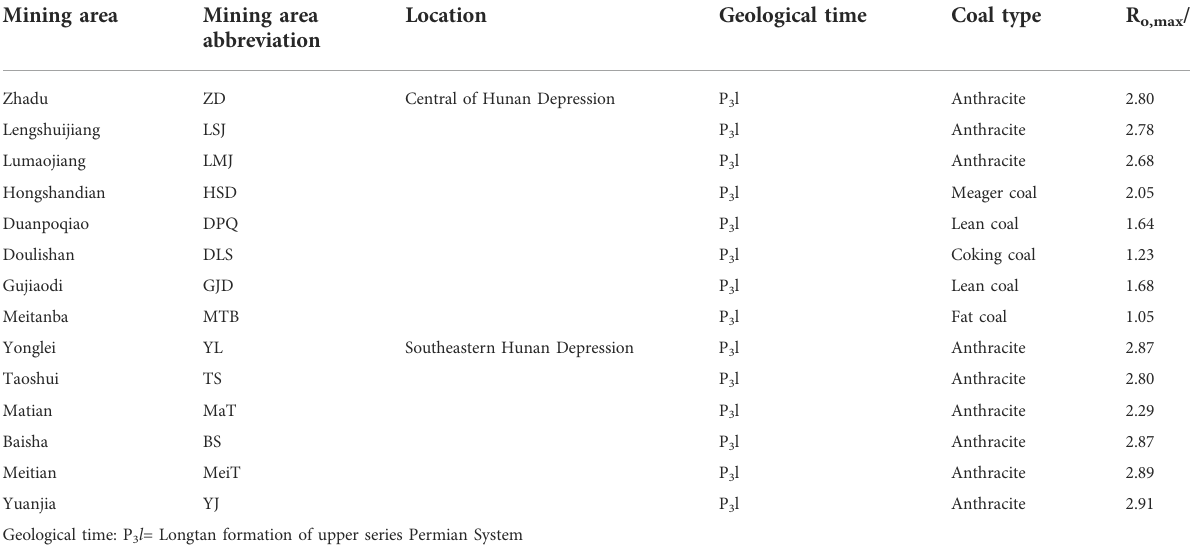
TABLE 1 Basic information of coal mines and